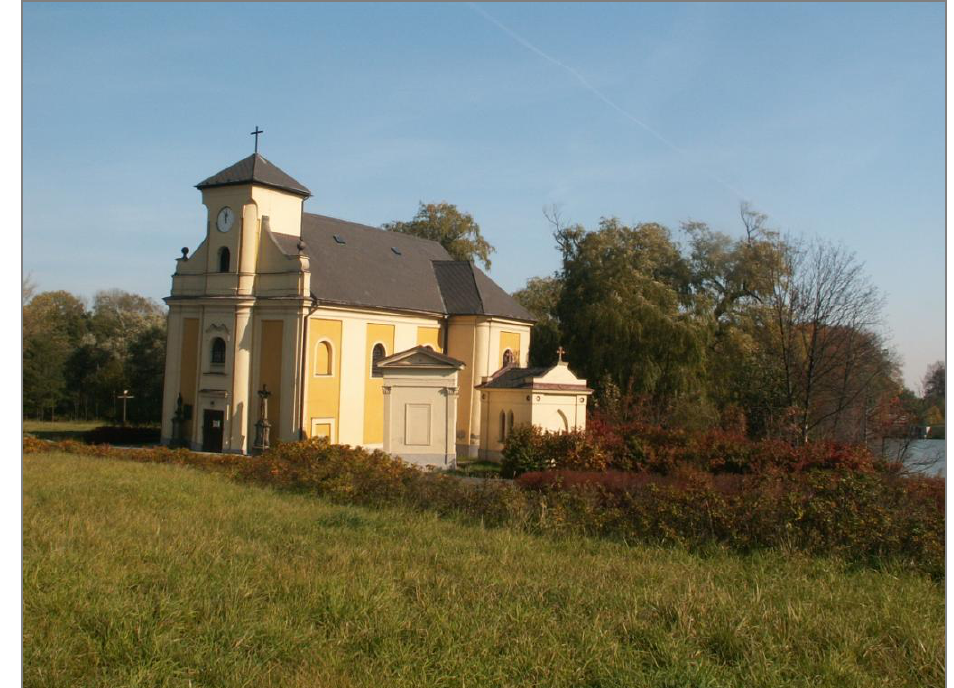
Fig. 2. The leaning Church of St. Peter of Alcantara, a cultural monument in the devastated and reclaimed area of Karviná – Doly ( J. Havrlant ,